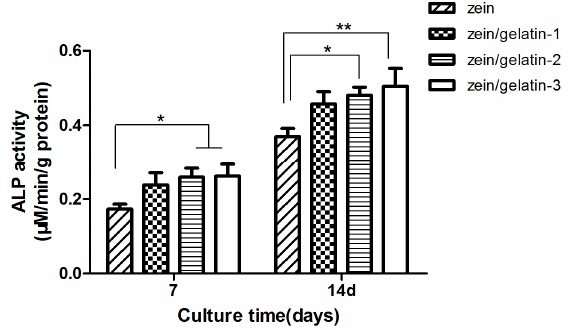
Figure 9. Alkaline phosphatase (ALP) activity of human PDLSCs after 7 and 14 days culture on zein, zein/gelatin-1, zein/gelatin-2, and zein/gelatin-3 nanofibrous membranes. (*), and (**) represent a statistical significance of p < 0.05 and p < 0.01, respectively.